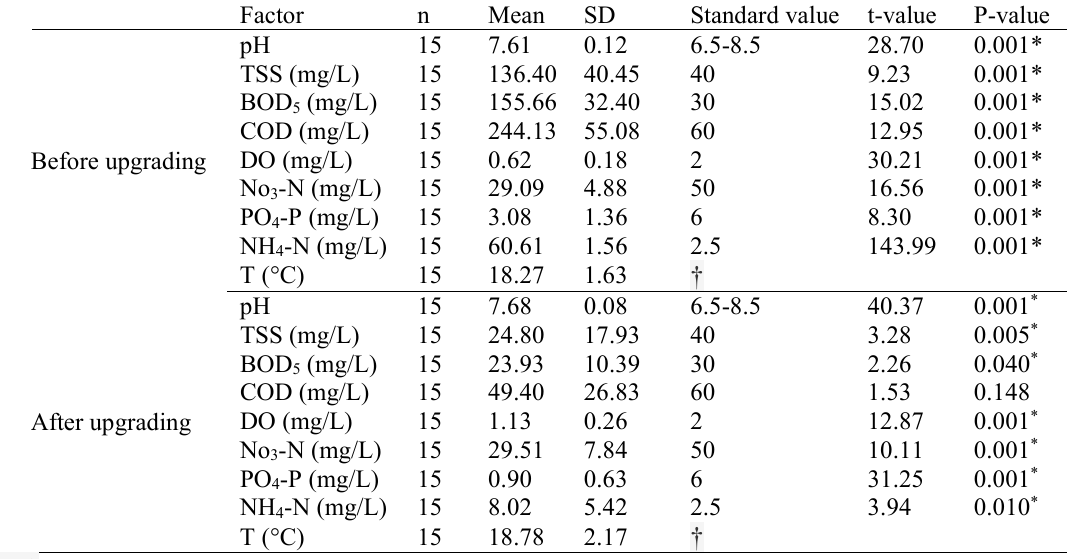
Table 7. Comparison of tafresh treated wastewater characteristics (before and after upgrading) to DoE